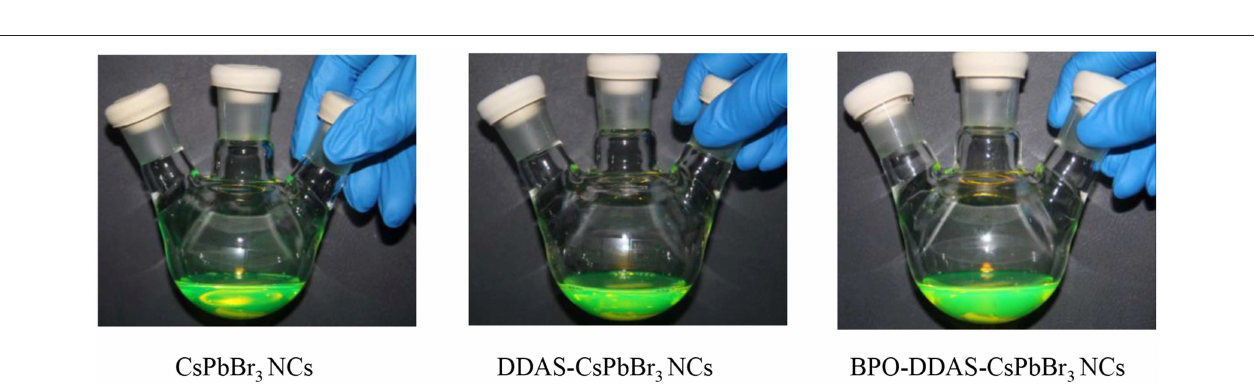
FIGURE 3 | Photographs of CsPbBr 3 NCs, DDAS-CsPbBr 3 NCs, and BPO-DDAS-CsPbBr 3 NCs.